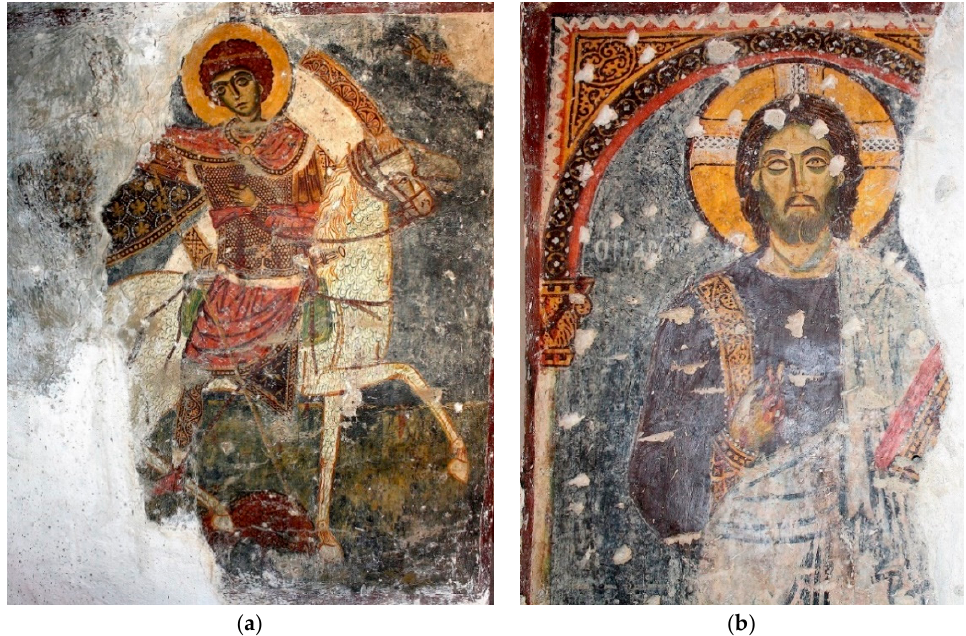
Figure 21. Mural paintings in the crossing of Hagios Nikolaos Mavrikas (Aegina), ca. 1330 ( a ) St George, east wall. ( b ) Pantokrator, north wall. © Author with the permission of the Ephorate of Antiquities of Western Attica, Piraeus, and Islands.